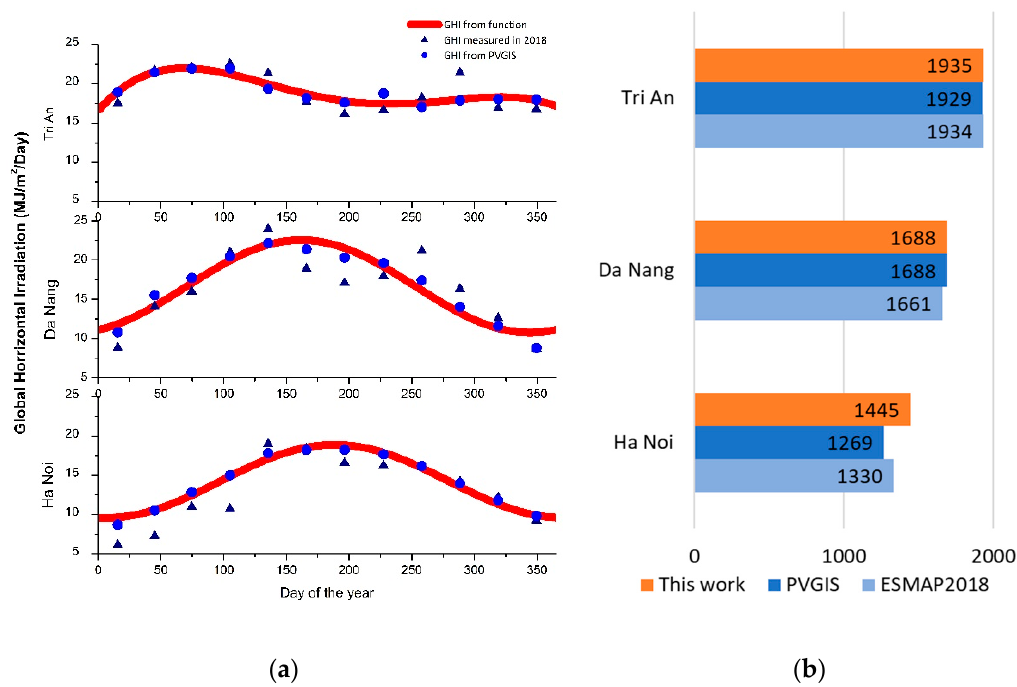
Figure 9. ( a ) Comparison between twelve values of the database and the fitted function of daily GHI ; ( b ) Comparison of total annual GHI at three regions in Vietnam.